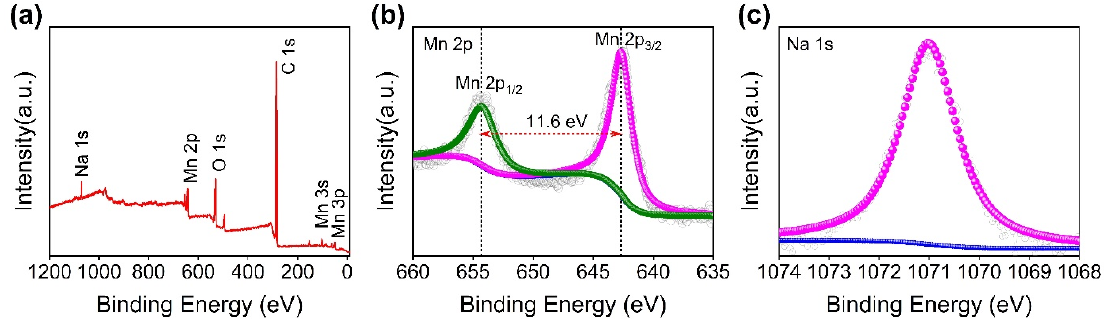
Figure 4. ( a ) Survey spectrum of Na 3 -MnO 2 ; ( b ) high-resolution spectrum of Mn 2p; ( c ) high-resolu- tion spectrum of Na 1s. resolution spectrum of Na